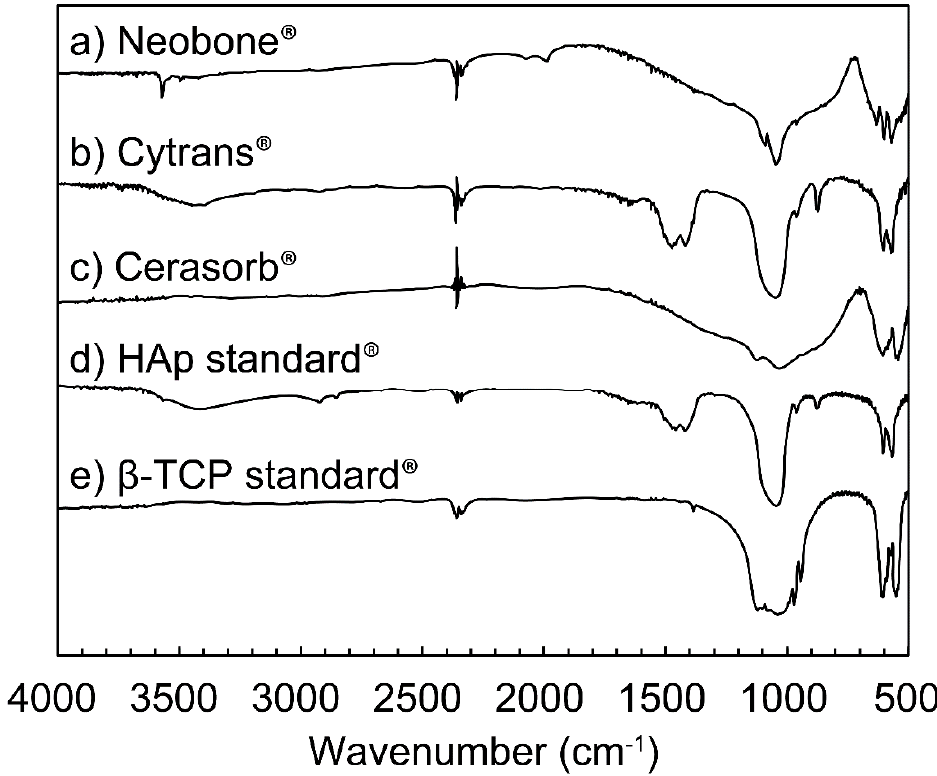
Figure 3. Fourier-transform infrared spectroscopy spectra of ( a ) Neobone ® (HAp), ( b ) Cytrans ® (CO 3 Ap), ( c ) Cerasorb ® ( β -TCP), ( d ) standard Hap, and ( e ) standard β -TCP.